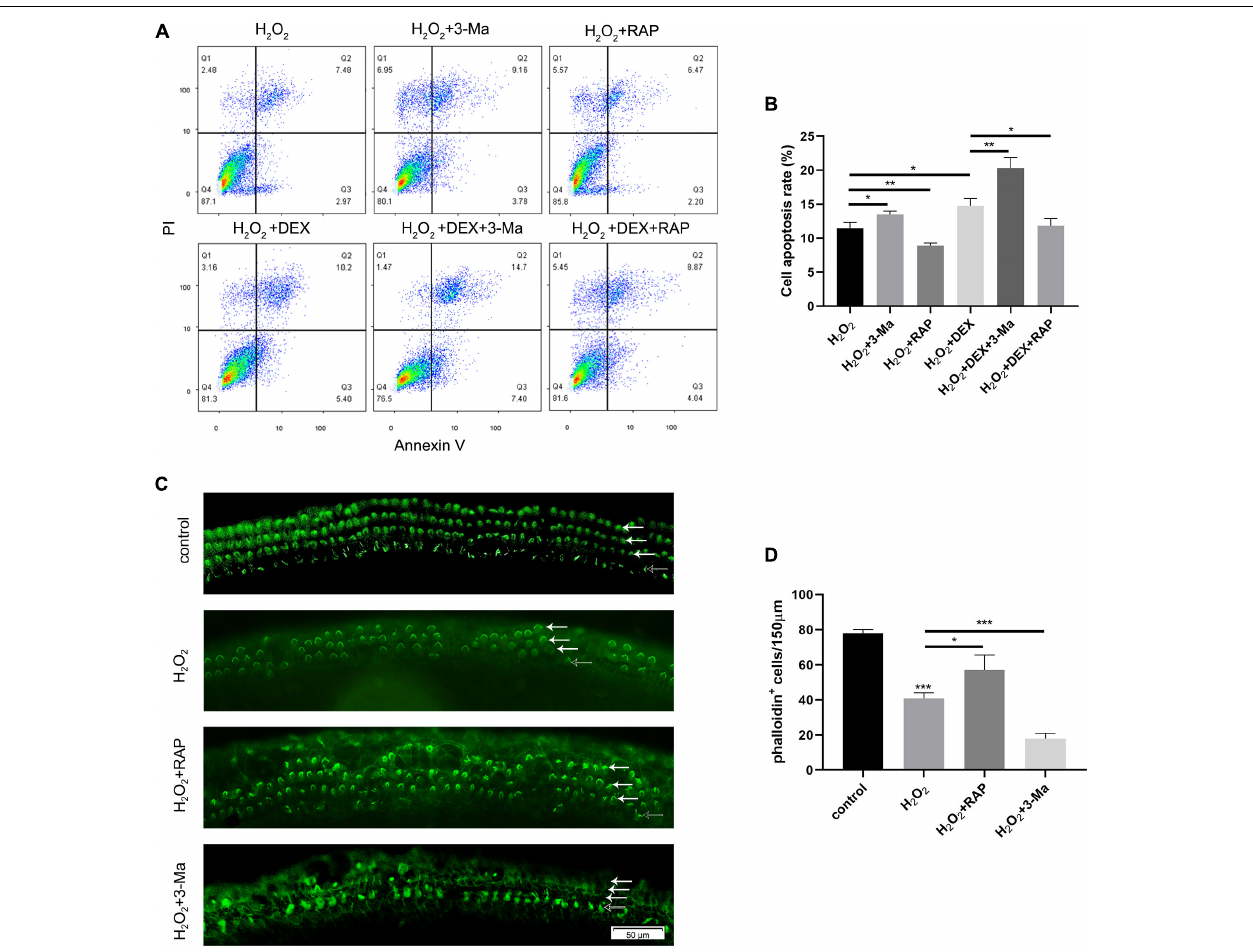
FIGURE 8 | Autophagy affected the apoptosis in HEI-OC-1 cells and the loss of hair cells (HCs) induced by H 2 O 2 (5 mM, 0.8 mM, respectively) exposure. (A) Flow cytometry for cell apoptosis analysis of different treatments, n = 3. (B) Quantification of the flow cytometry data of (A) . The proportions of apoptotic cells could be increased by 3-MA and decreased by rapamycin. Rapamycin treatment partly prevented the increased HEI-OC-1 cells apoptosis induced by dexamethasone and H 2 O 2 . (C) Phalloidin labeling showed HCs survival in the cochleae after H 2 O 2 damage with 3-MA or rapamycin preconditioning. (D) Quantification of the phalloidin-positive HCs in (C) , n = 3. The HCs loss induced by H 2 O 2 were partly prevented by rapamycin treatment but aggravated by 3-MA treatment. The data are shown as the mean ± SD. Two-tailed, unpaired Student’s t -tests were used to determine statistical significance.